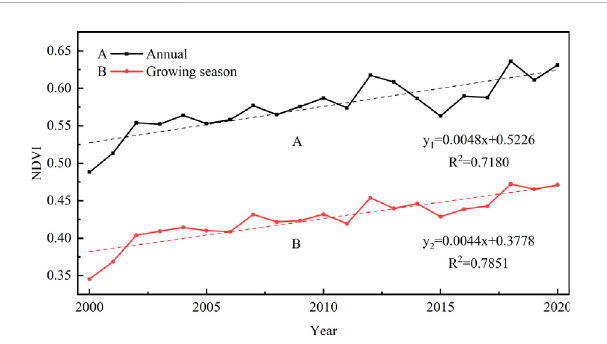
FIGURE 6 Temporal trends in the NDVI from 2000 to 2020. (A) Annual; (B) Growing